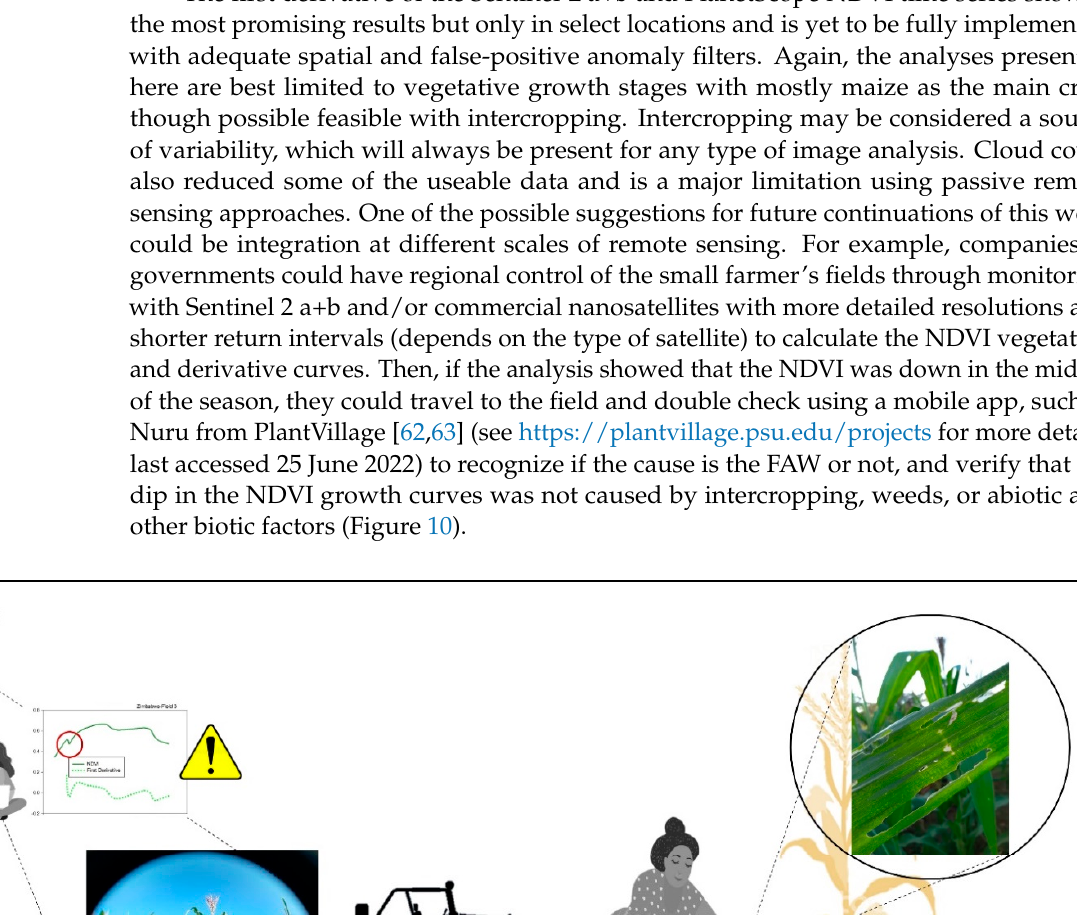
(left) and PlanetScope (right) along the first season of maize from the end of April to the end of July. Figure S3. NDVI curves of vegetation from Kenya (continue green line) and the first derivative of NDVI curves (dashed light green line) were taken from Sentinel 2 a+b